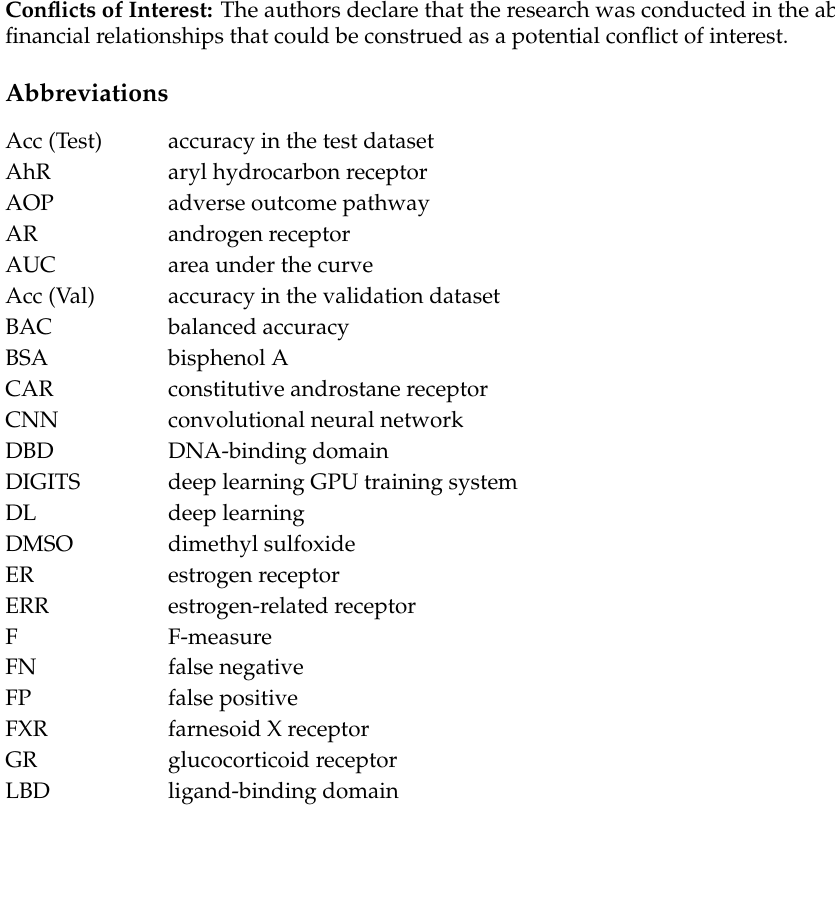
Figure S1. DeepSnap-DL procedure, Figure S2. Schematic illustrating how preparation of Tra / Val / Test datasets. Figure S3. Schematic view of GoogeLeNet archirecture. (a) Total layers used in this study. (b) Inception model within the GoogLeNet. Figure S4a. Average Accuracy values in Val and Test datasets in models of 35 NRs agonist / antagonist by the DeepSnap-DL. N = 2. Figure S4b. Average F and BAC values in Test dataset in models of 35 NRs agonist / antagonist by the DeepSnap-DL. N = 2. Figure S5. Comparison of prediction performances dataset. Table S1: NRs and chemical compounds used in this